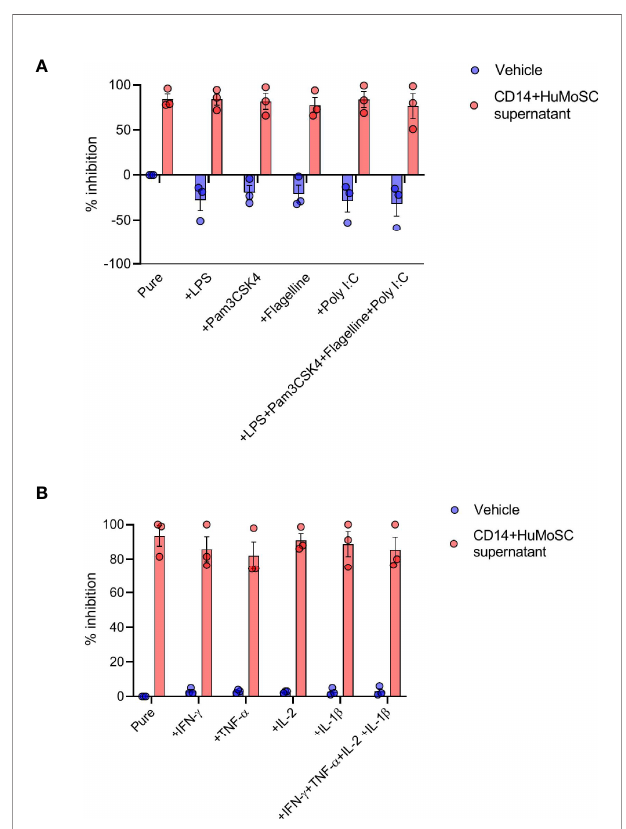
FIGURE 4 | In fl ammatory environment does not dampen CD14+HuMoSC supernatant immunosuppressive functions. (A) 500 000 Cell-Trace Violet labeled PBMC stimulated with anti-CD3/CD28 microbeads for 4 days were co-cultured in presence of LPS (50ng/mL), PAM3CSK4 (50ng/mL), fl agellin (50ng/mL), Poly I:C (50µg/mL) or a combination of them and CD14+HuMoSC supernatant. PBMC proliferation is shown in 3 independent experiments. (B) 500 000 Cell-Trace Violet labeled PBMC stimulated with anti-CD3/CD28 microbeads for 4 days were co-cultured in presence of IL-2 (20IU/mL), IFN- g (25ng/mL), TNF- a (25ng/mL), IL-1 b (25ng/mL) or a combination of them and CD14+HuMoSC supernatant. PBMC proliferation is shown in 3 independent experiments. Data are shown as mean ± SEM of representative